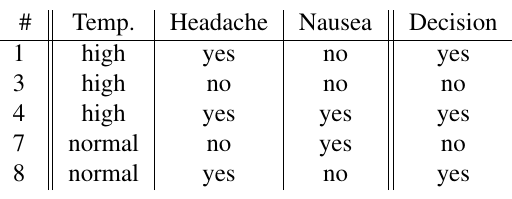
Table 3. Small Patient’s Decision